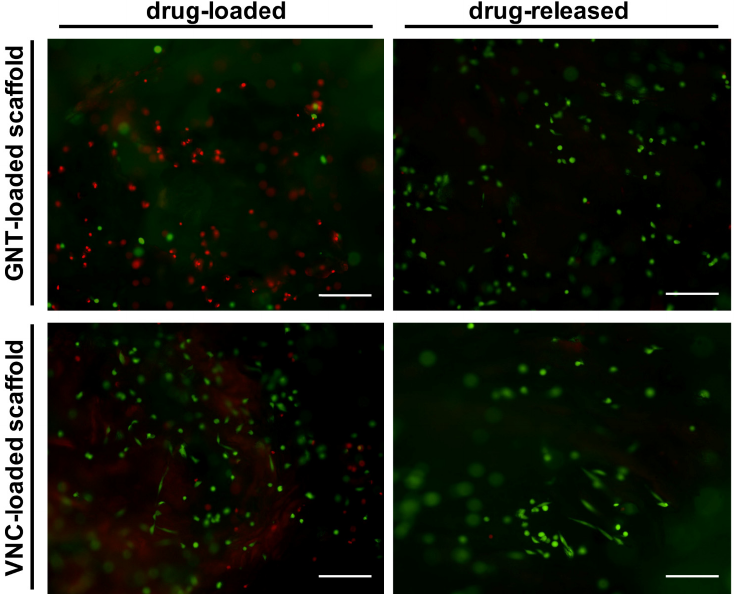
Figure 8. Qualitative cell viability analysis performed with a live/dead kit 1 day after seeding. Calcein AM labels living cells in green by using FITC filter (EX 465-495; BA 515-555), ethidium homodimer-1 labels dead cells in red by using TRITC filter (EX 515-565; BA 550-660). Scale bar: 200 μ m.